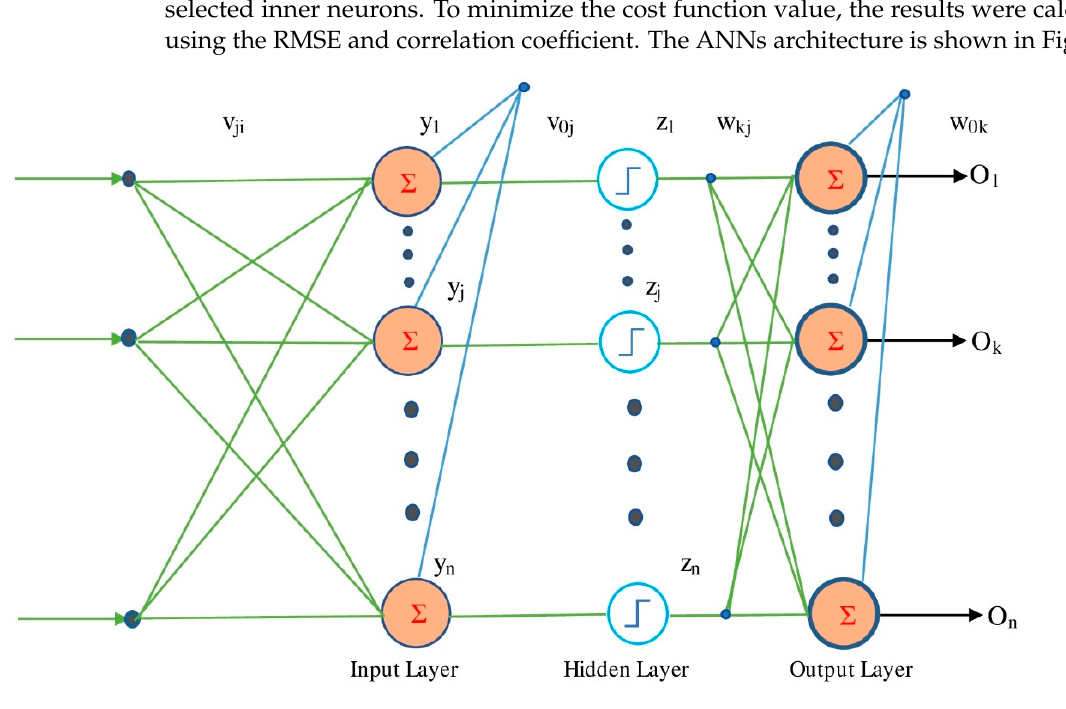
Figure 1. Architecture of an artificial neural network.